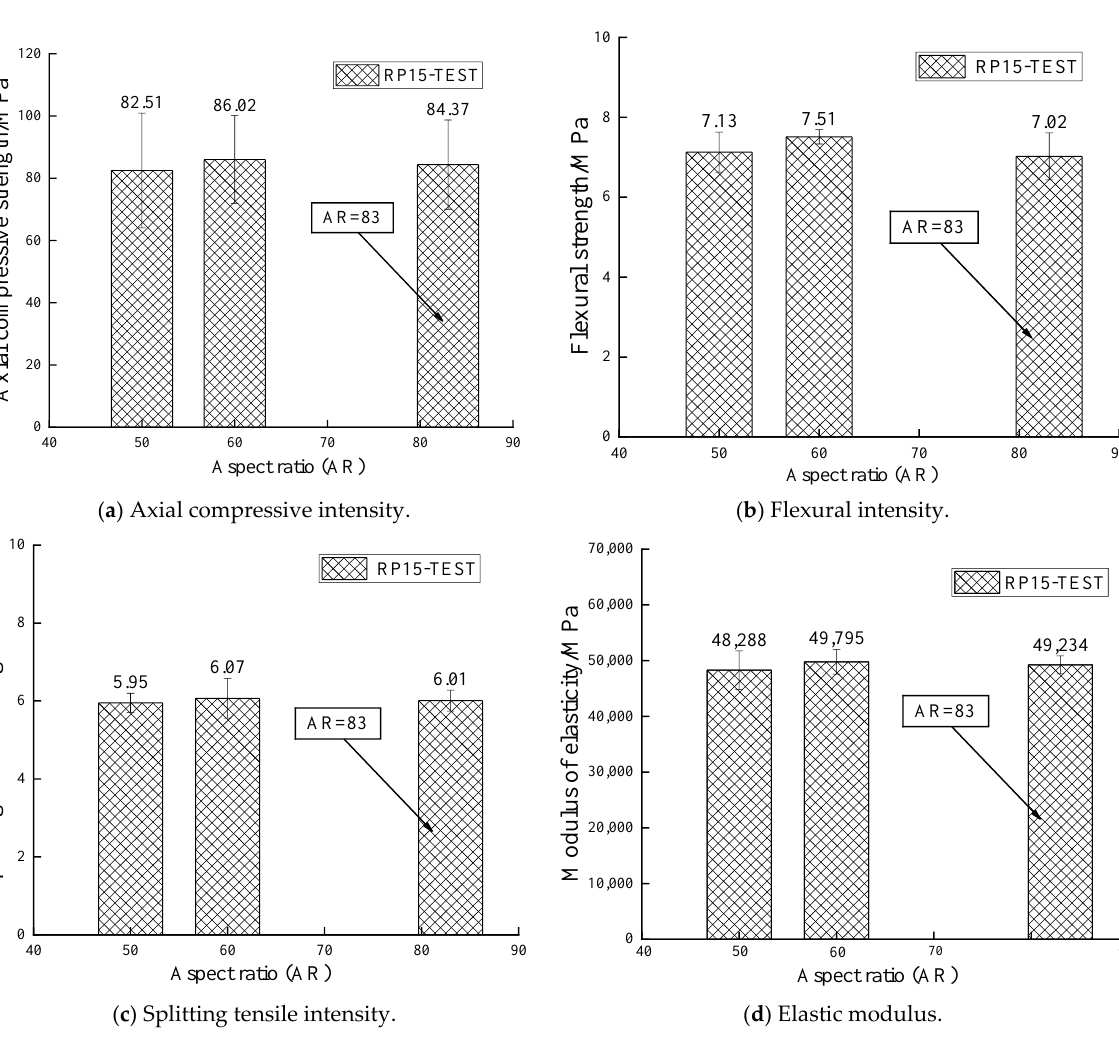
Figure 6. Mechanical characteristics of concrete with 15% LP with different steel fiber length-to- diameter ratios.